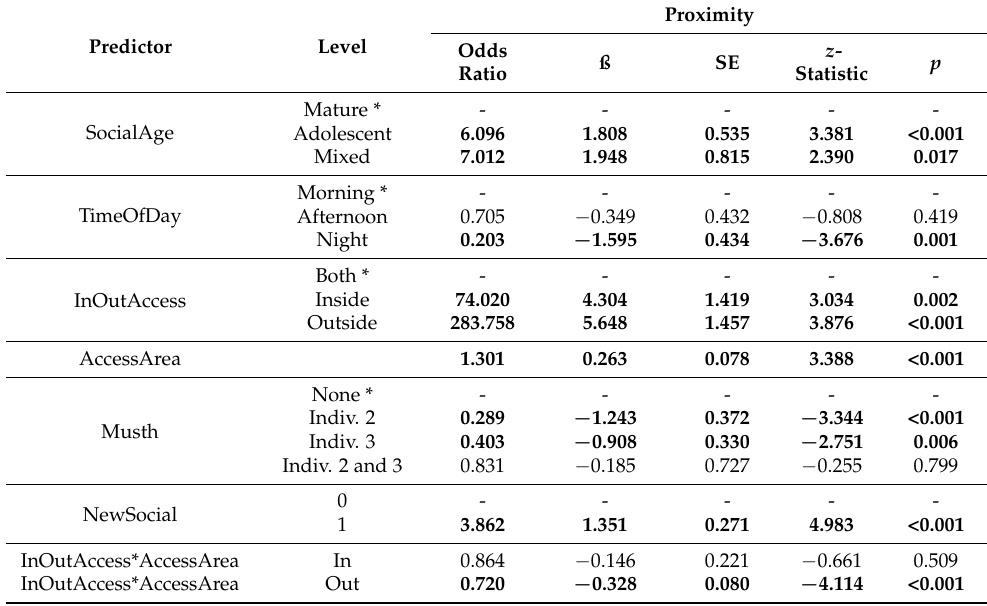
Table A9. Mature GLMER model parameter estimates for proximity response variable. Generalized linear mixed-effect model results of associations between predictor variables (fixed effects) and proximity response variable for mature focal animals. ß = Beta coefficients from model outputs: positive values indicate an increase in odds compared to the reference level while negative values indicate a decrease in odds compared to reference level; SE = standard error of beta coefficients; Wald X 2 = Chi-squared statistic from Wald test with df = 1; p = p -value from Wald test. * indicates reference level. Bold signifies statistical significance ( p <